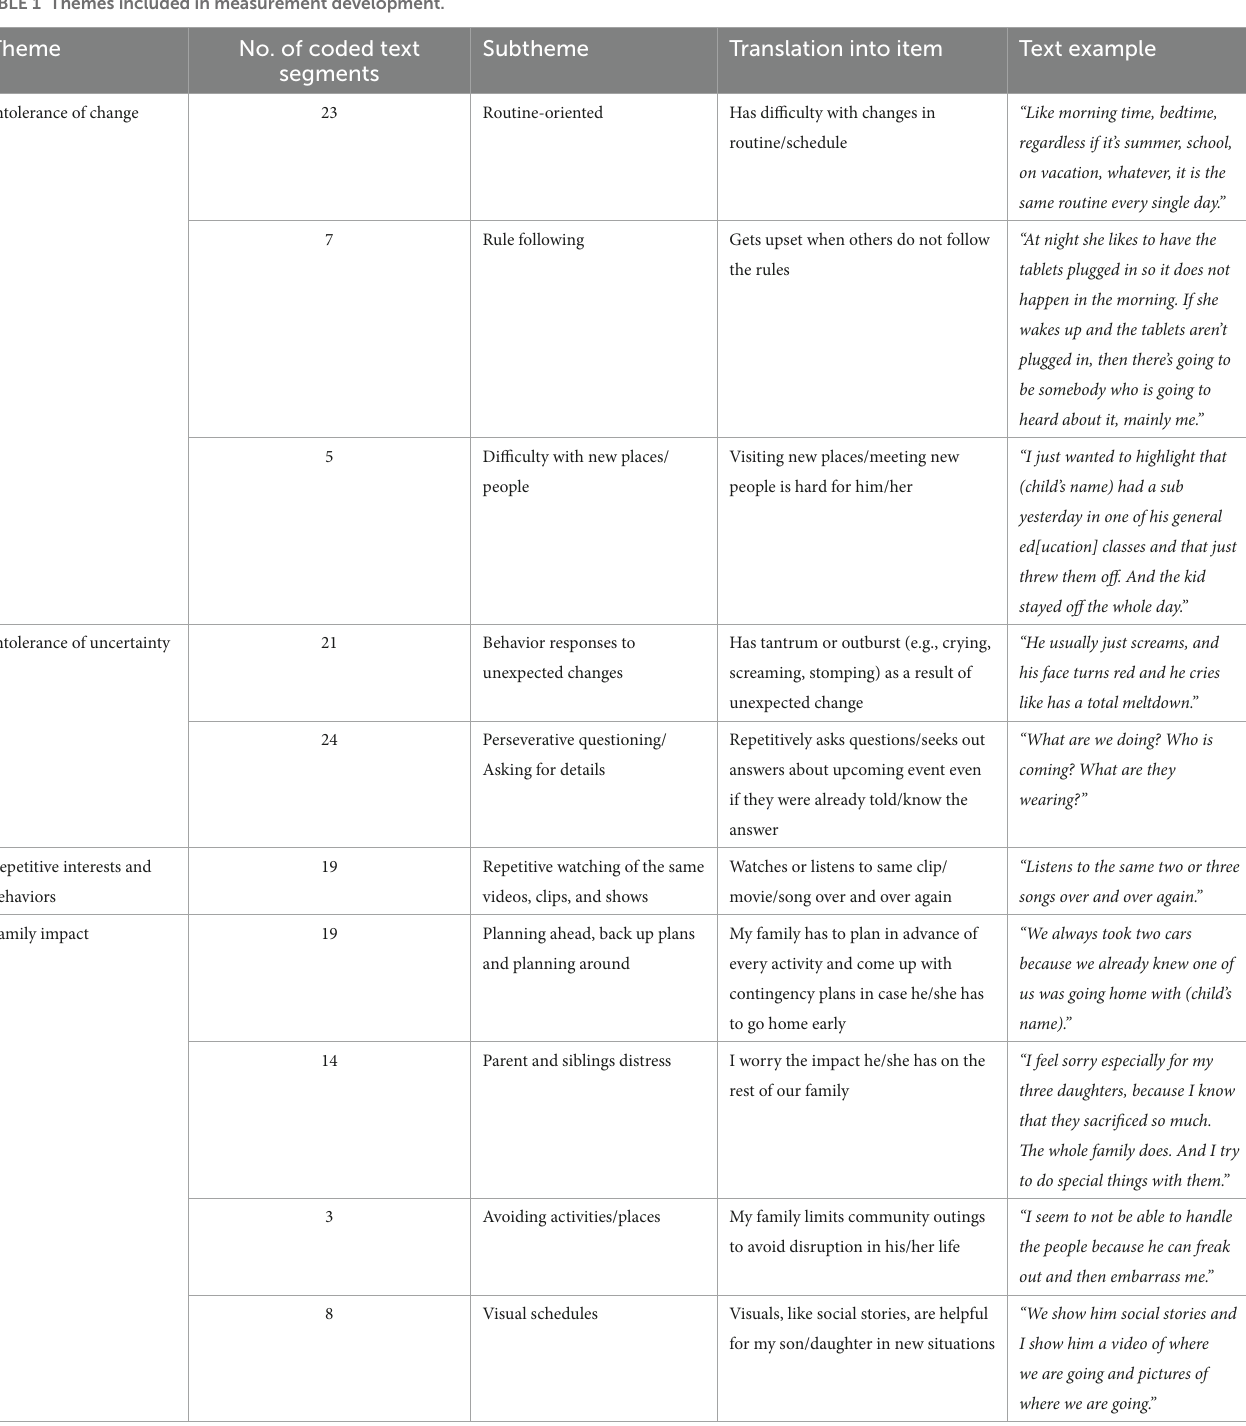
TABLE 1 Themes included in measurement